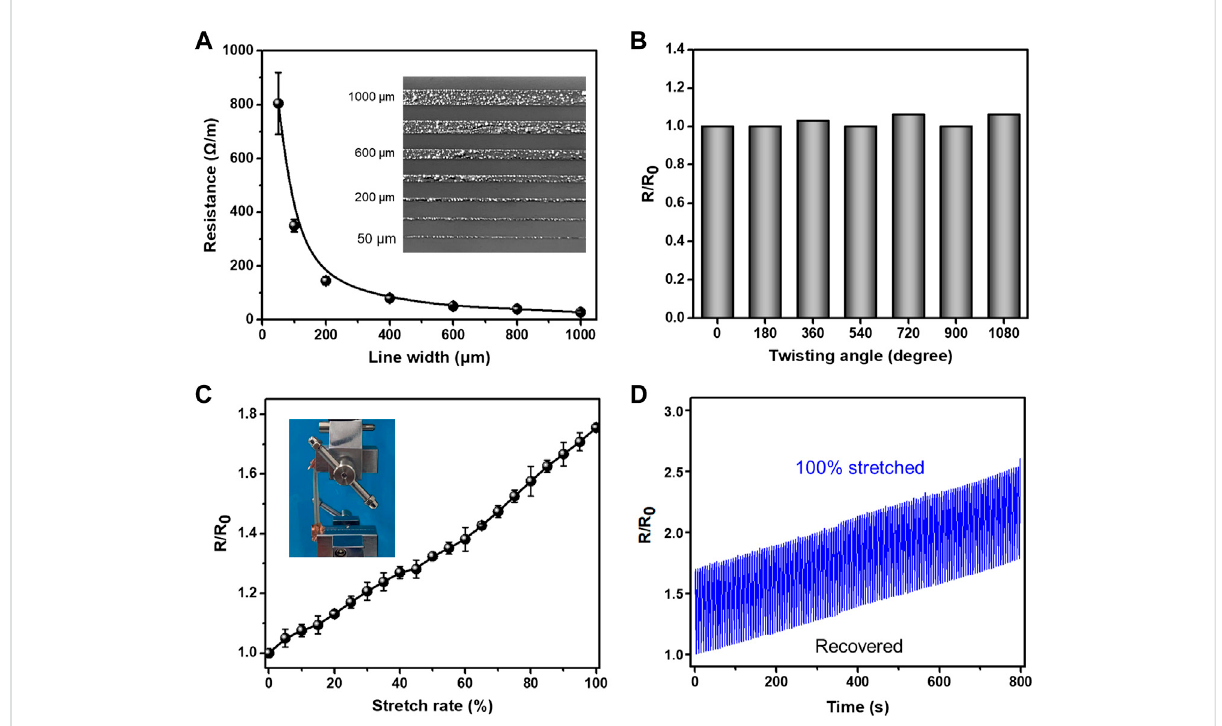
Conductivity of printed liquid metal lines. (A) Relationship between the resistance of liquid metal lines and their line widths. (B) In fl uence of the resistance on different twisting angles. (C) Variation of the resistance with stretch rate increasing. (D) Reversible switching of the resistance with repeated stretching and